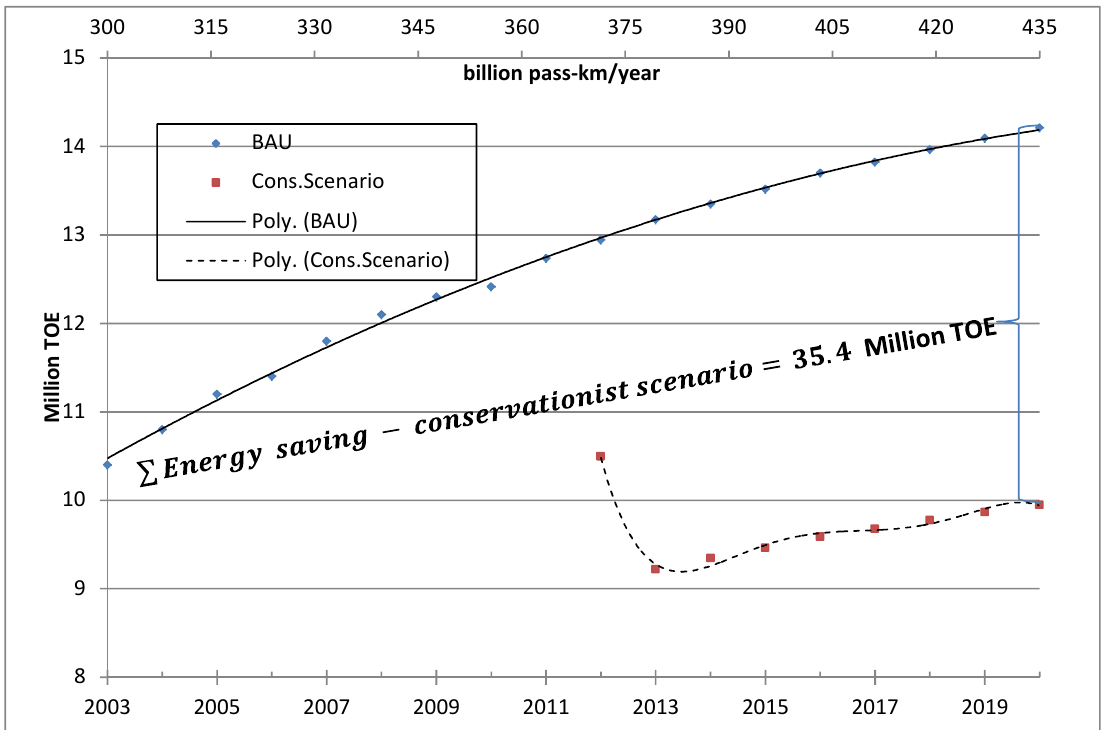
Figure 9. Trend of Energy Consumption versus Potential Reduction in Passenger